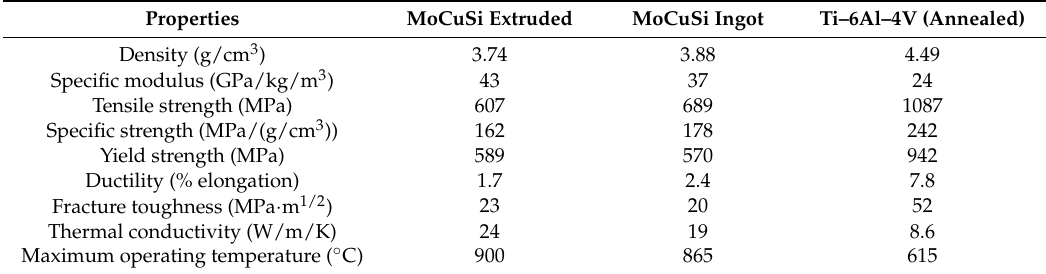
Table 1. Properties of different TiAl alloys (courtesy of GfE ® Metalle und Materialien GmbH).